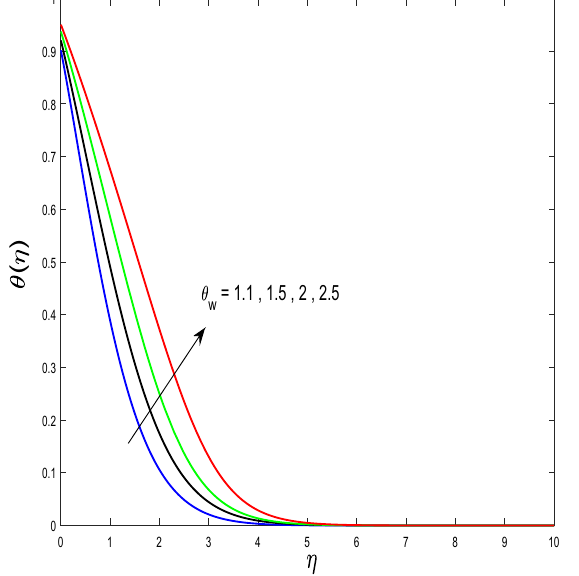
Figure 7. Plot of θ for θ w .